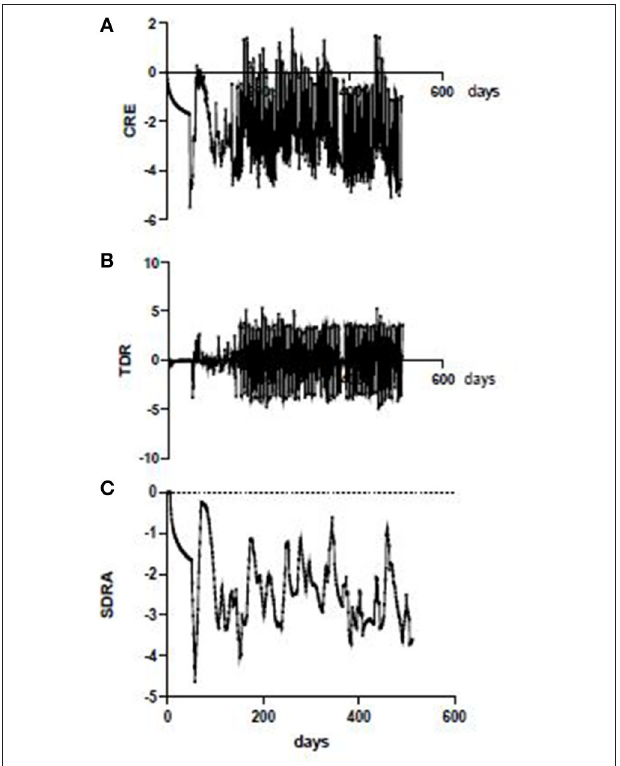
FIGURE 4 | CRE iterations, Western Australia. Daily (spot) CRE in WA showing swinging variations due in part to reporting breaks over weekends (top); nett 3-day rise in CRE (TDR) showing effect of weekend reporting artefact (middle); 7 day rolling average CRE in WA with irregular fluctuation independent of weekend reporting artefact